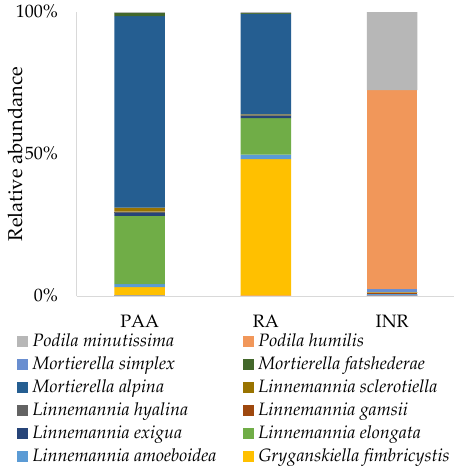
Figure 6. Abundance of the species belonging to Mortierellomycota in soil samples taken from the Polluted AgroEcosystem (PAE), the AgroEcosystem (AE), and the integral natural reserve (INR).